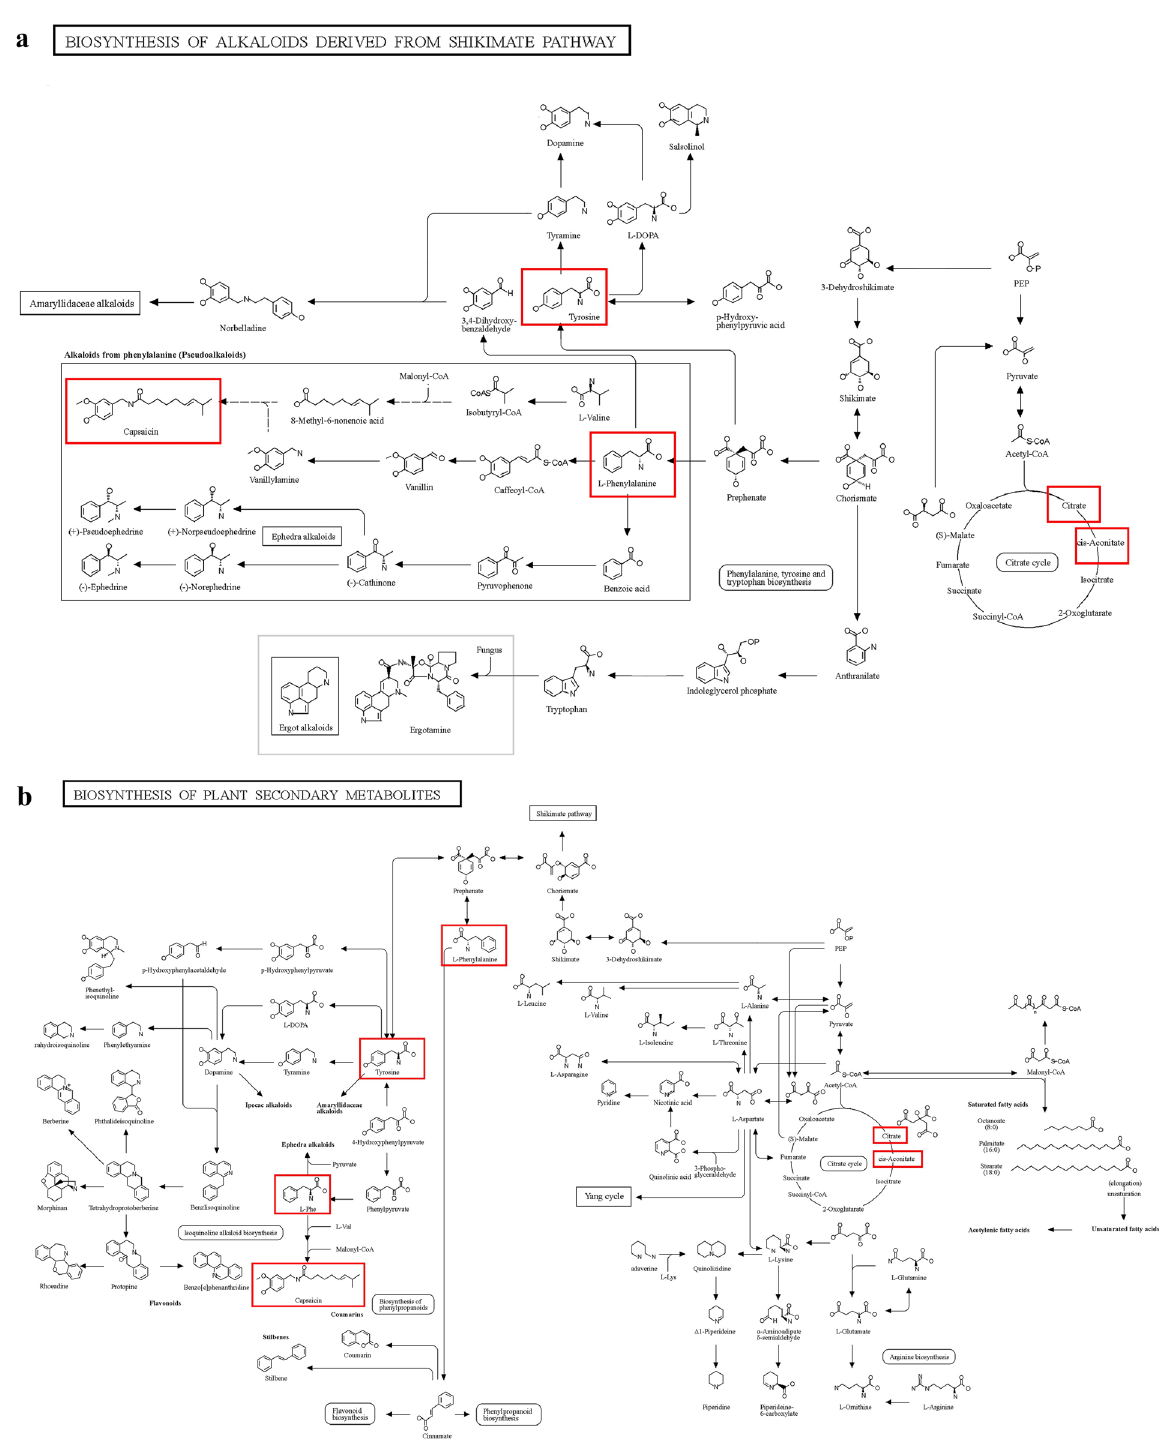
Figure 5. ( a ) Biosynthesis of plant secondary metabolites pathway. ( b ) Biosynthesis of alkaloids derived from shikimate